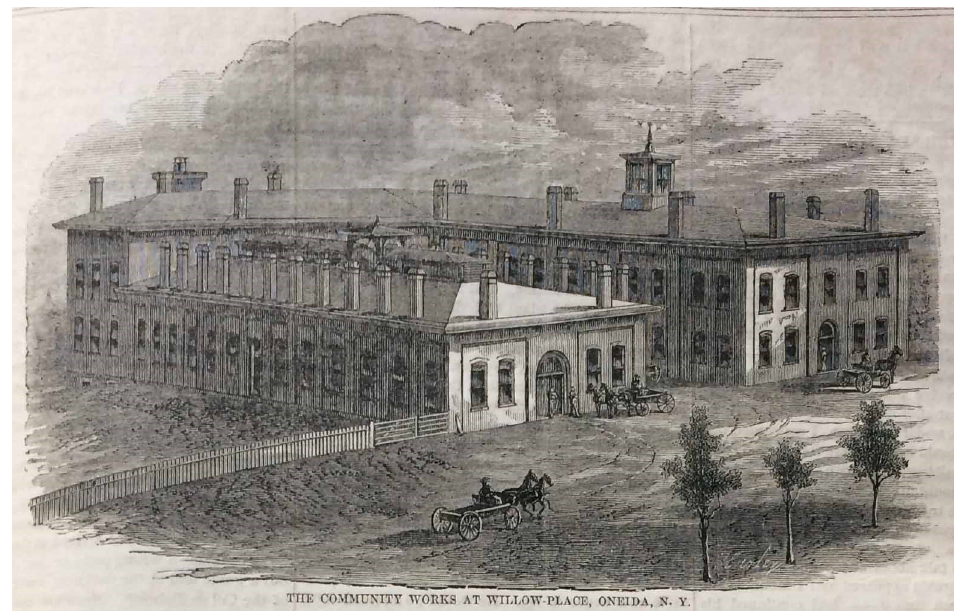
Figure 1 Oneida Community Willow Place factory. The Circular , 19 August 1867, 179. In the public